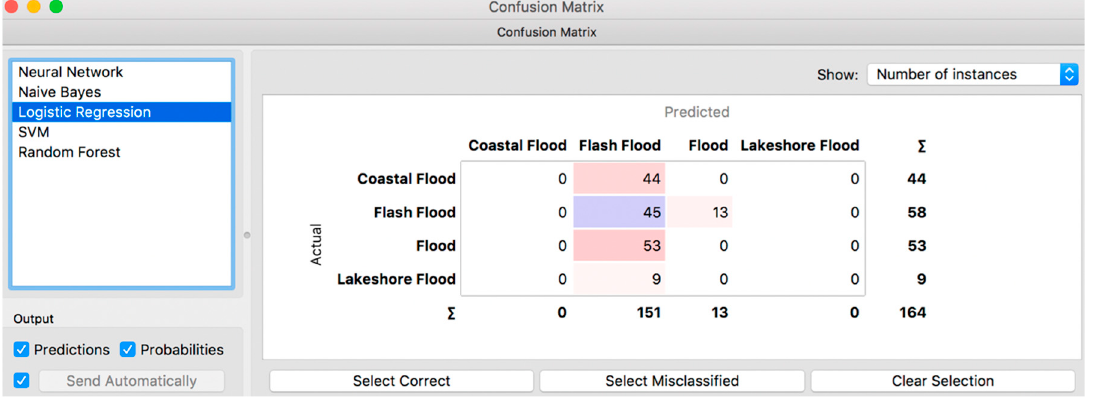
Figure 12. Evaluation Results for Logistic Regression model in Orange.